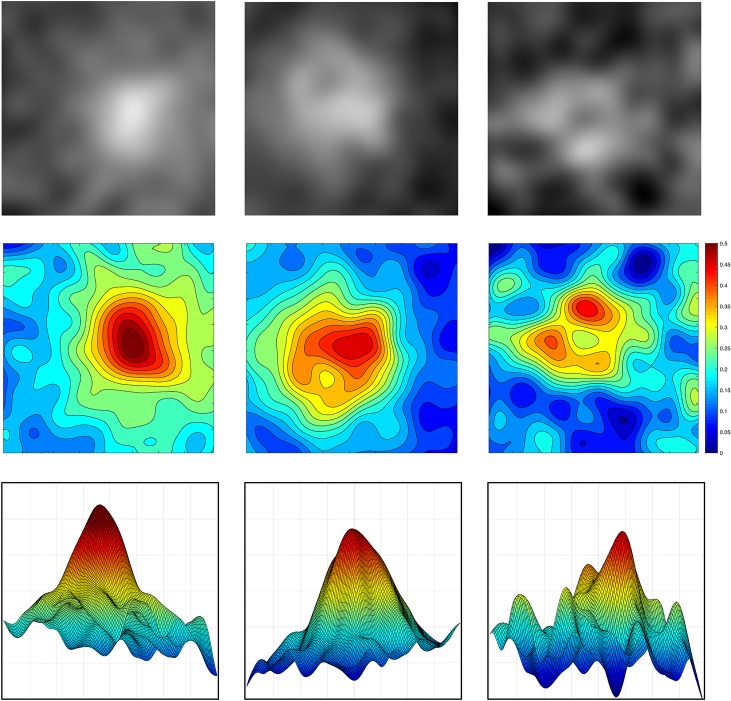
Examples of MRIA maps showing the magnitude and distribution of the macular pigment in subjects from group 1 (left), group 2 (centre) and group 3 (right). Top row: original MRIA maps of MP with brightness proportional to MP level; middle row: visualisation of MP as contour maps, derived from the original MRIA maps; bottom row: visualisation of MP as 3D elevation maps. The bar on the right shows the MP concentration (A.U.). The maps represent a region with eccentricity of 4 degrees centred on the fovea. All the MP maps are publicly available at the University of Birmingham eData Repository, “Macular pigment maps and groups”, https://edata.bham.ac.uk/153/.